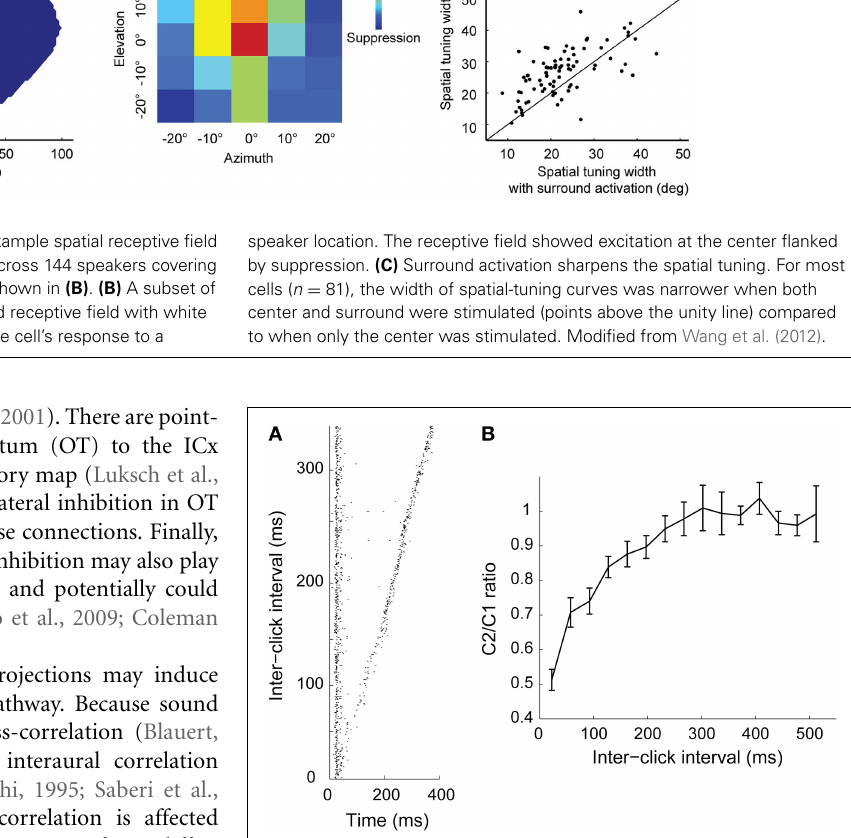
FIGURE 2 | Adaptation time course in ICx. (A) Pairs of 1ms clicks (C1 and C2) presented at various inter-click intervals. When the onset of the two clicks was close in time, response to the second click decreased relative to the first one. (B) Ratio between responses to C1 and C2 as a function of inter-stimulus interval ( n = 44). Response to C2 was significantly attenuated when the interval was less than 300ms. From Wang and Pena